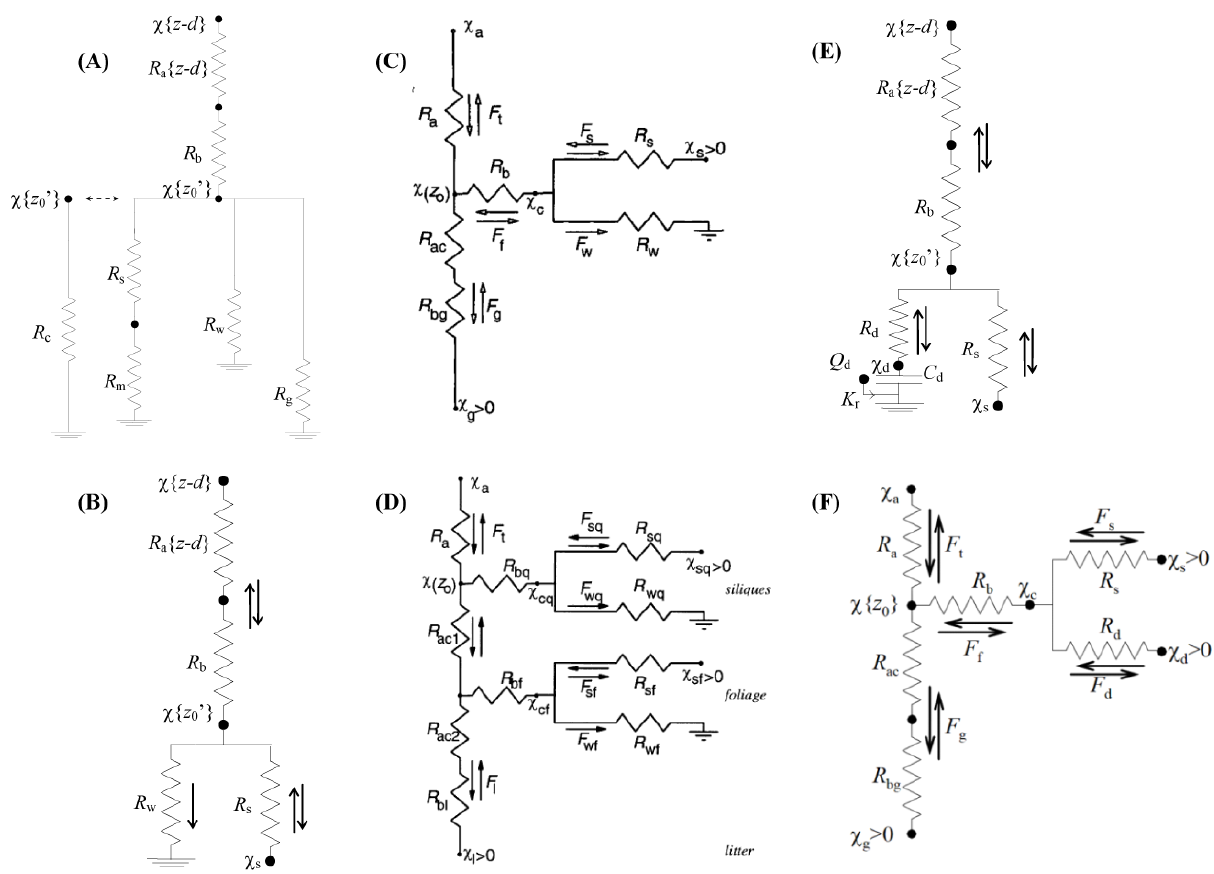
Fig. 7. Typical surface/atmosphere schemes for the modelling of net canopy-scale NH 3 fluxes. (A) Generic example of canopy resistance ( R c ) model; (B) the 1-layer χ s /R w canopy compensation point model by Sutton et al. (1995b); (C) the 2-layer χ s /χ g /R w canopy com- pensation point model by Nemitz et al. (2001a); (D) the 3-layer (soil, foliage, silique/inflorescence) canopy compensation point model by Nemitz et al. (2000b); (E) the 1-layer χ s /χ d /R d capacitance canopy compensation point model by Sutton et al. (1998a); and (F) the 2-layer χ s /χ g /χ d /R d dynamic chemistry canopy compensation point model by Burkhardt et al.